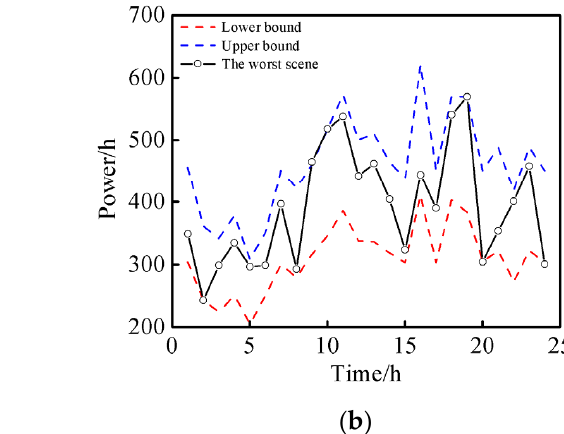
Figure 10. Worst scenario set of Subsystem 1 under Scenario 4. ( a ) Photovoltaic. ( b ) Electric load.